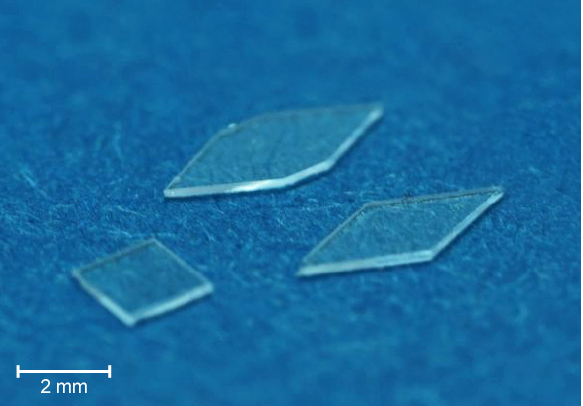
Figure 1. Glass sensor bodies as dummies for simulating the integration of a MEMS vibrometer [9] into a laminate. The glass inlays are constructed from BOROFLOAT33 borosilicate glass wafers with a thickness of 200µm and shaped using a wafer-dicing